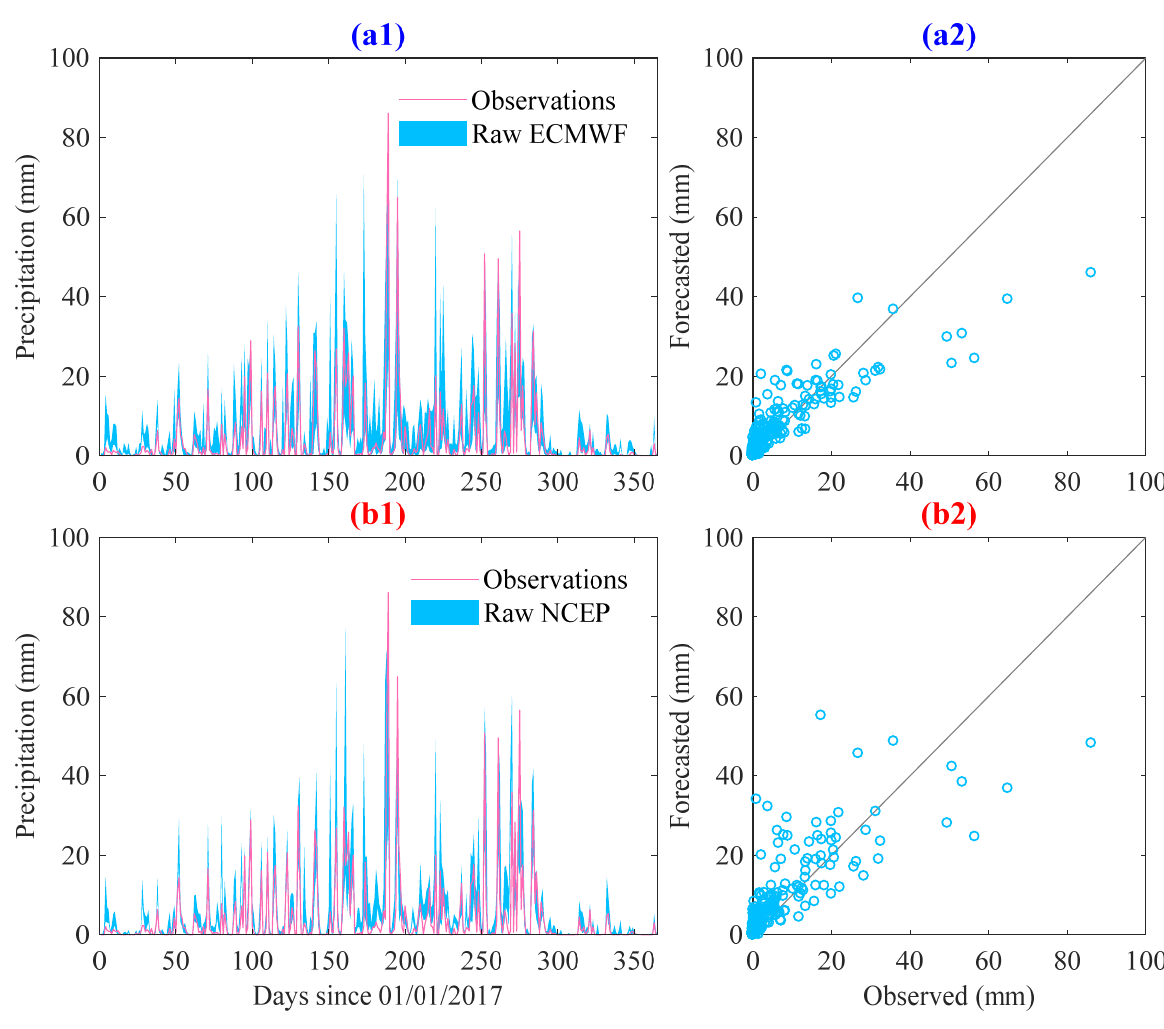
Figure 3. Comparison of daily observed precipitation and raw EPFs from ECMWF ( a1 , a2 ) and NCEP ( b1 , b2 ) at 1 lead day during 2017. ( a1 , b1 ) are the time series of forecast and observed precipitation; ( a2 , b2 ) are the scatter plots of ensemble mean forecast and observed precipitation.